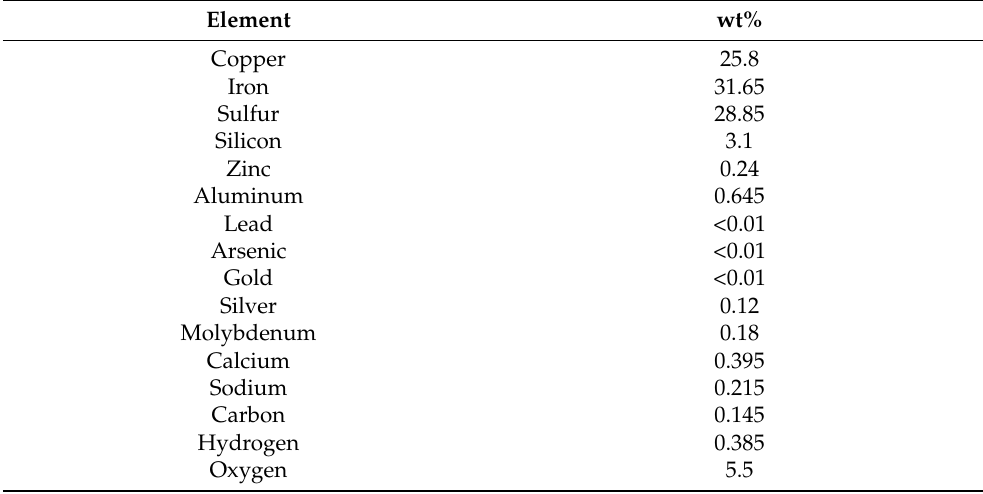
Table 1. Elemental composition of the initial chalcopyrite concentrate feed from FreePort McMoRan, average of two samples measured by ICP-MS and LECO.